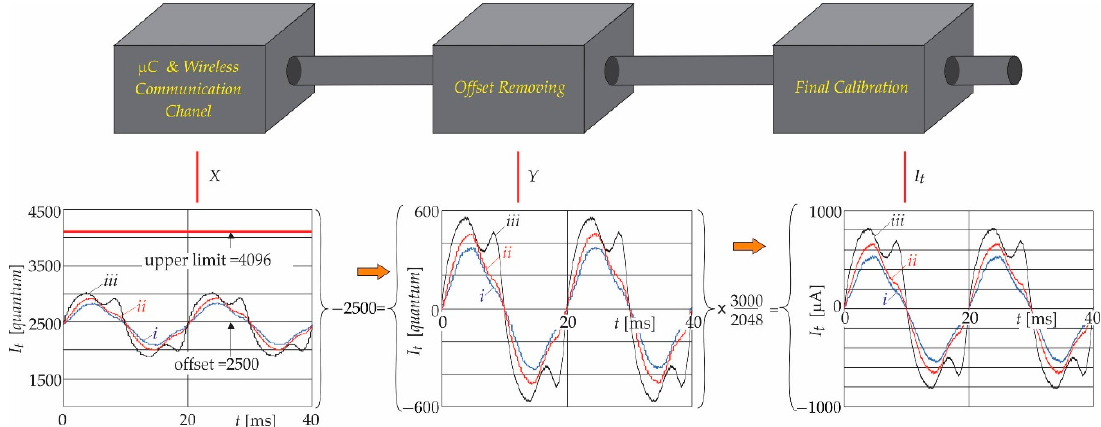
Figure 12. Calibration procedure; the roman letters i , ii and iii indicate measurements at 0.80 U , 1.00 U , and 1.20 U , respectively.